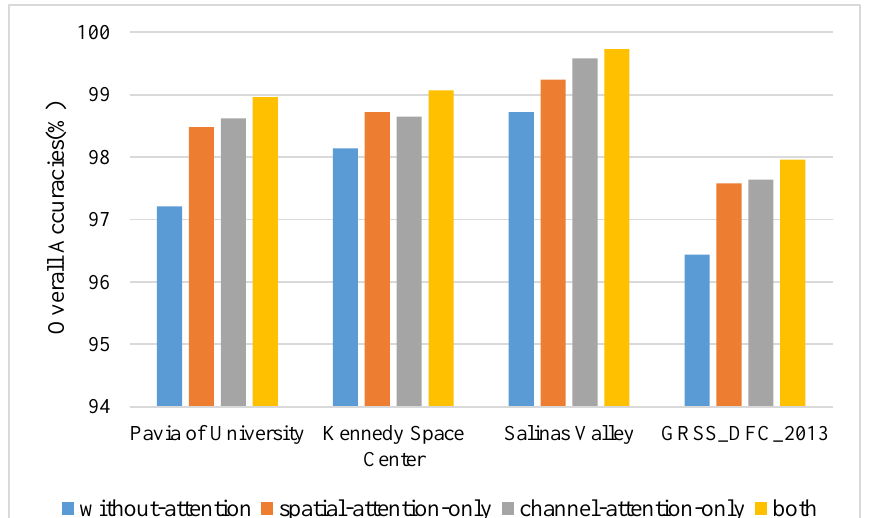
Figure 7. The overall accuracies of ablation experiments on four datasets.